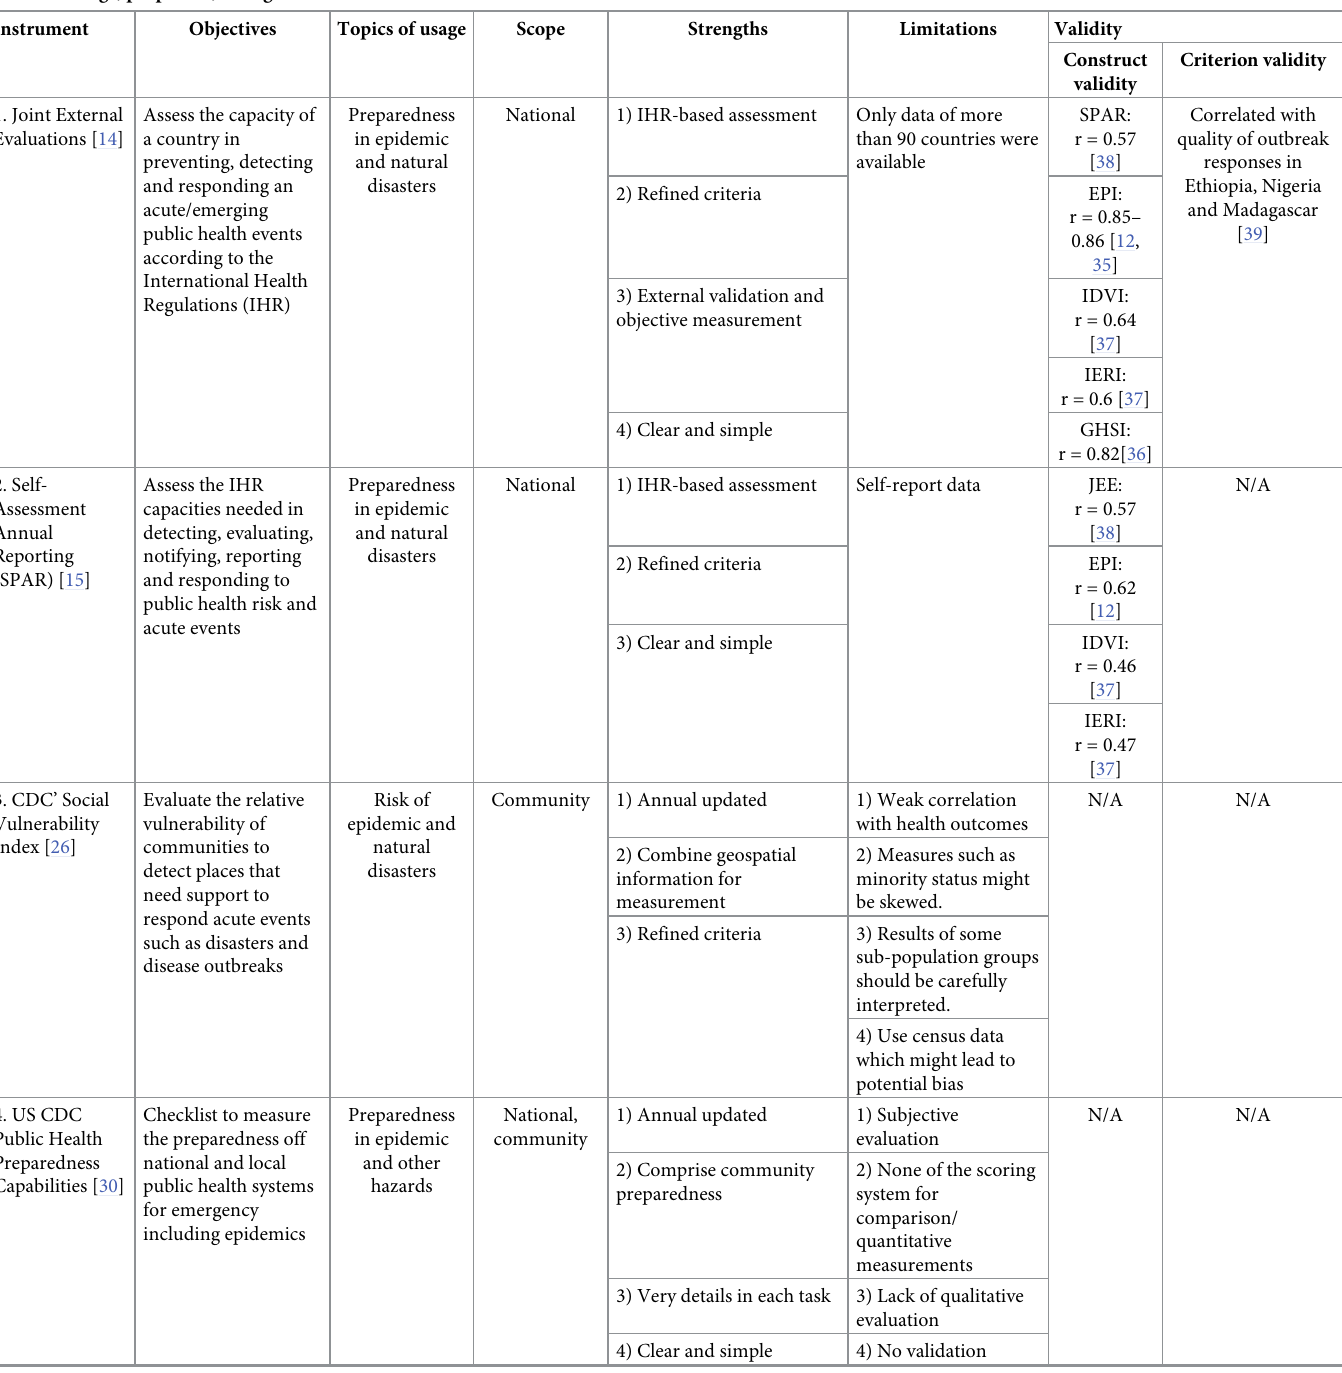
Table 5. Usage, properties, strengths and limitations of risk assessment